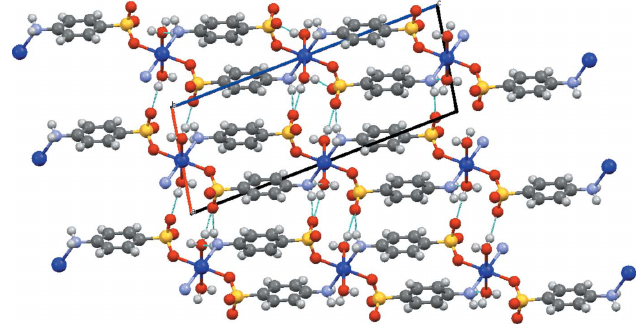
molecules and SO 3 (cid:3) groups in the title compound.